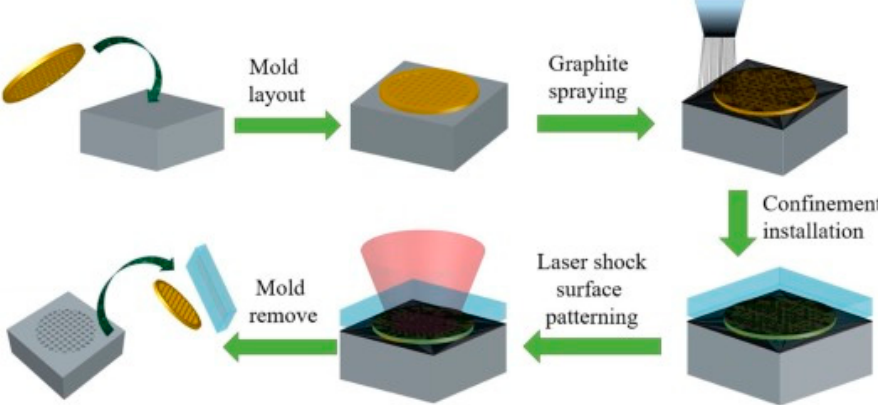
Figure 21. A schematic illustration of indirect-LSSP process. Reproduced with permission from [146]. Copyright Elsevier, 2018.